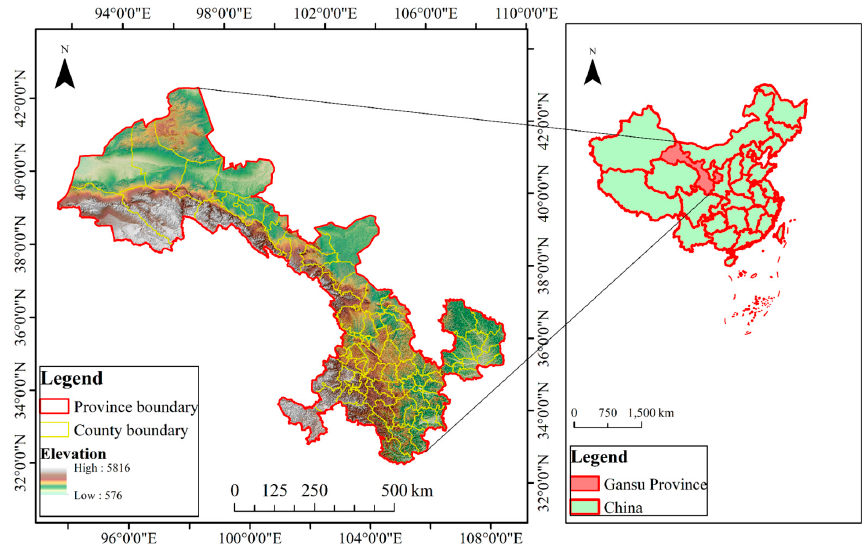
Figure 1. Location of Gansu Province.